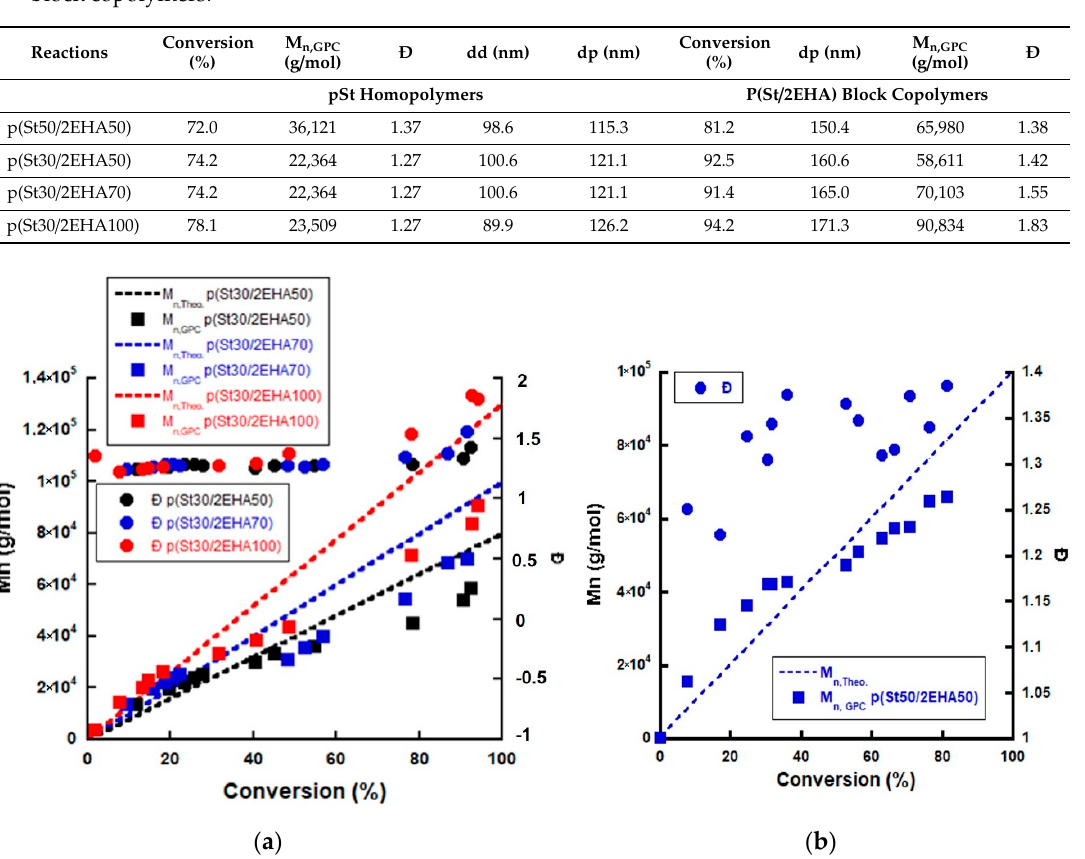
Table 1. Conversion, average particle size (dd: diameter of the droplets; dp: diameter of the particles), Mn, and Ð at the end of reaction for pSt homopolymers and p(St/2-ethylhexyl acrylate (2EHA)) block copolymers.